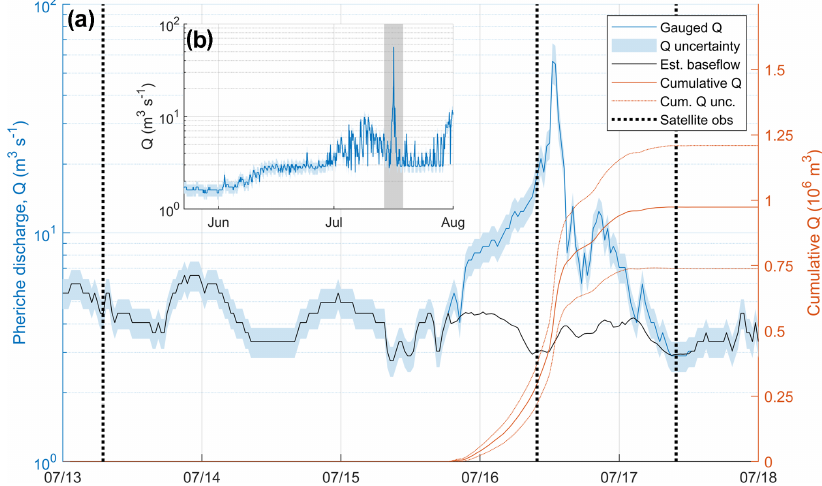
Figure 7. Pheriche discharge record during the outburst flood and cumulative flood volume, also indicating the timing of PlanetScope observations (a) . The discharge record throughout the 2017 monsoon (b) . Note the log scale for discharge in both